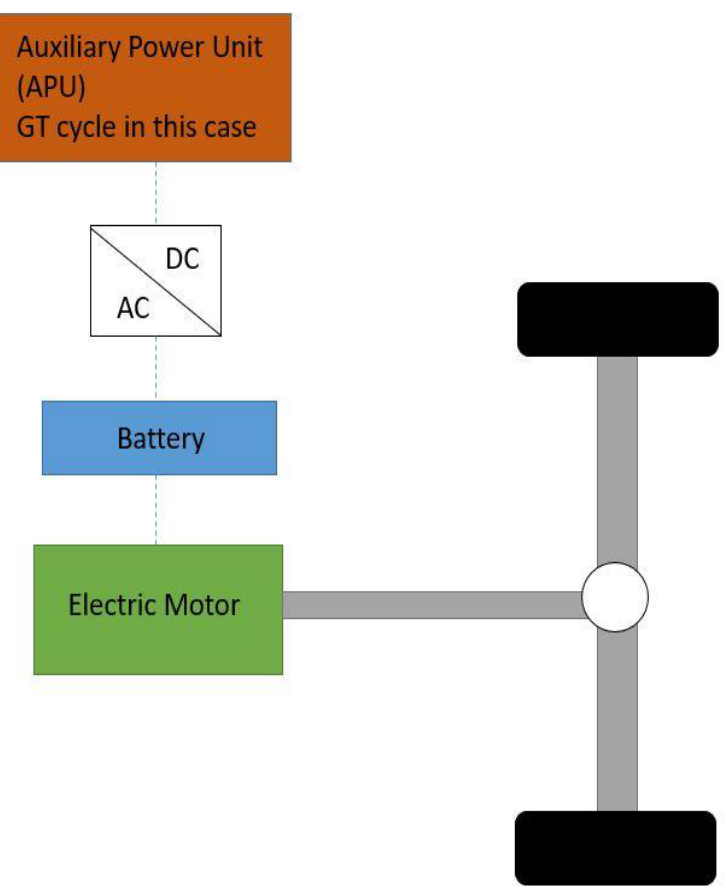
Figure 1. Gas turbine as an auxiliary power system for series hybrid electric vehicles.